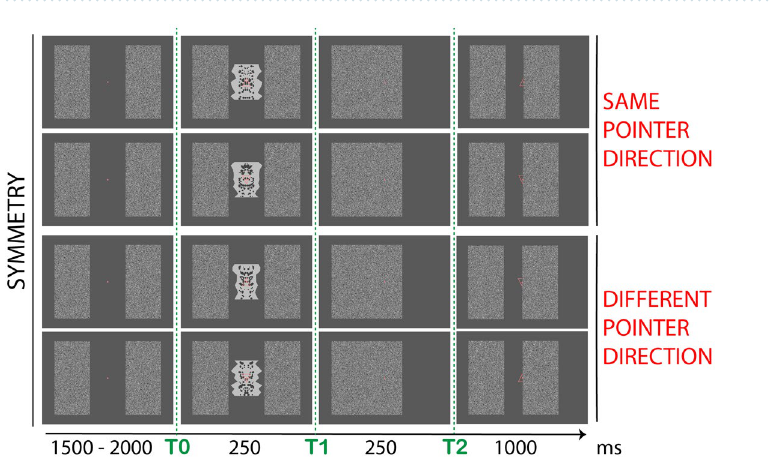
Figure 8. Experiment 4. The design was similar to the other experiments. A red triangle was presented at fixation, superimposed to the symmetric shape in t0. It pointed either upwards or downwards. In t2 no shape was presented behind the occluder; only the triangle pointing towards either the Same or Different direction (participants attended the triangle/pointer direction). In the figure only combinations for symmetry and right occluder displacement are shown. Same combinations were obtained for asymmetry and left occluder (all counterbalanced across